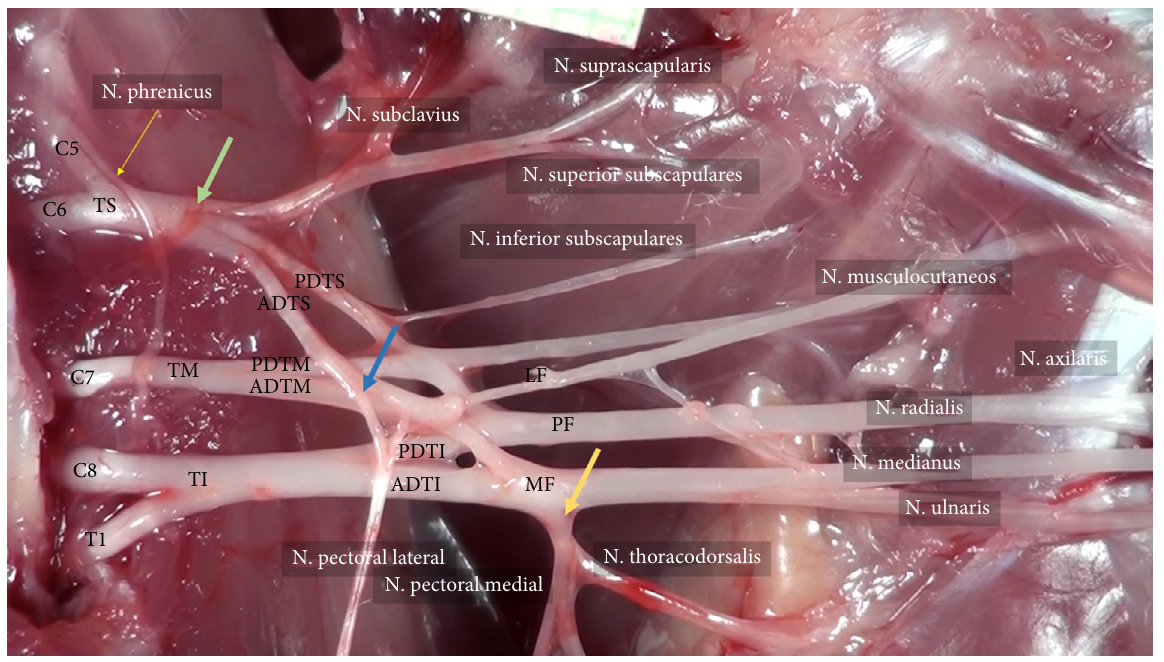
Figure 1 - A common formation of plexus brachialis in rat. C5, C6, C7, C8, and T1: ventral roots of the PB; TS: truncus